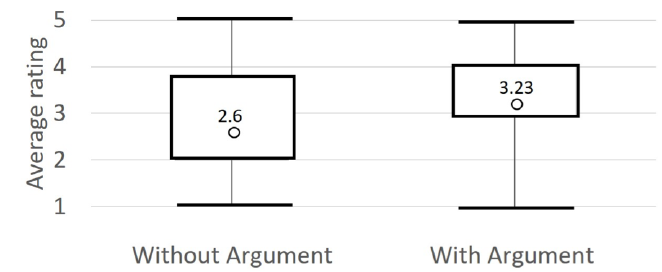
Figure 3. Average ratings provided by the students without and with arguments and their associated